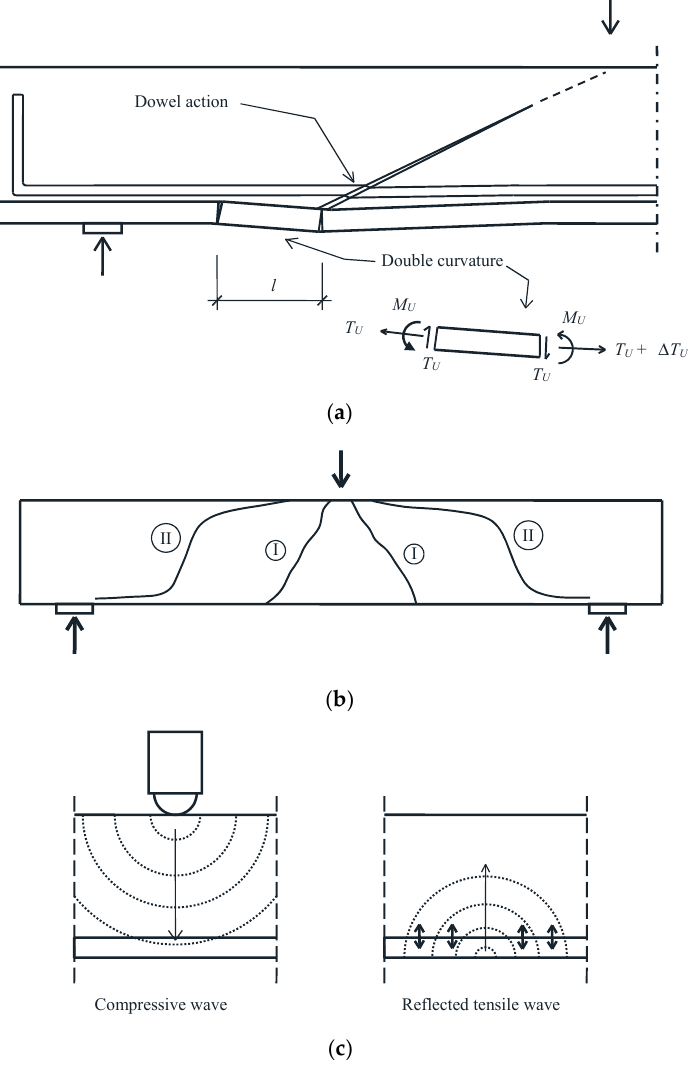
Figure 7. Shear resisting mechanisms. ( a ) Contribution of the HPFRC by bending in double curvature; ( b ) types of shear cracks in impact tests; ( c ) interface debonding due to reflected impact wave.